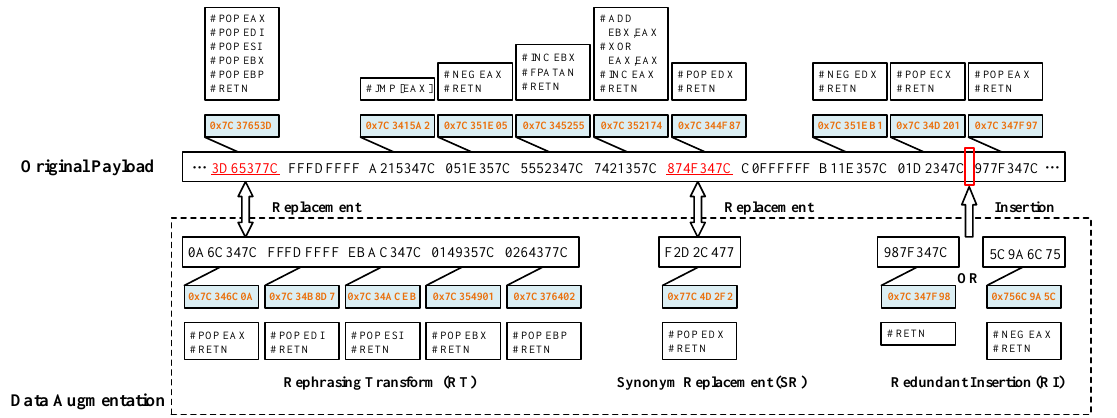
Figure 8. Schematic diagram of proposed function-preserving data augmentation on a malicious sample.